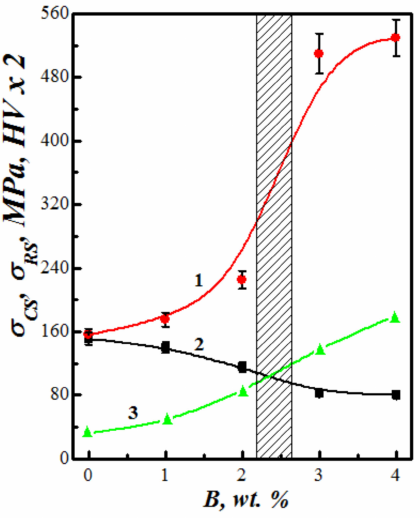
Figure 11. Hardness HV (1), cohesive strength σ CS (2) and residual stresses σ RS (3) in coatings versus boron content B in ASCs deposited by spraying of CW B(0...4) Ni4Ti2Al2. Hatching high- lights the zone of optimal boron content in the coating to provide the best combination of the analyzed